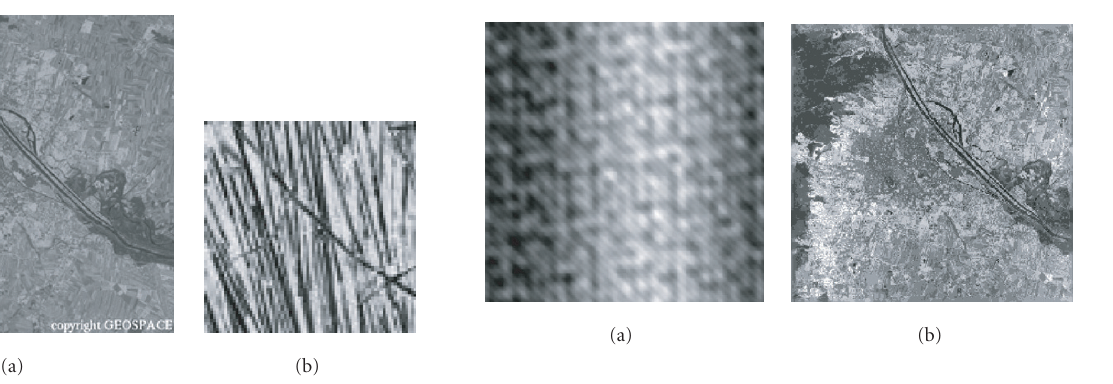
Figure 2: (a) Deterministic component and (b) pure random com-